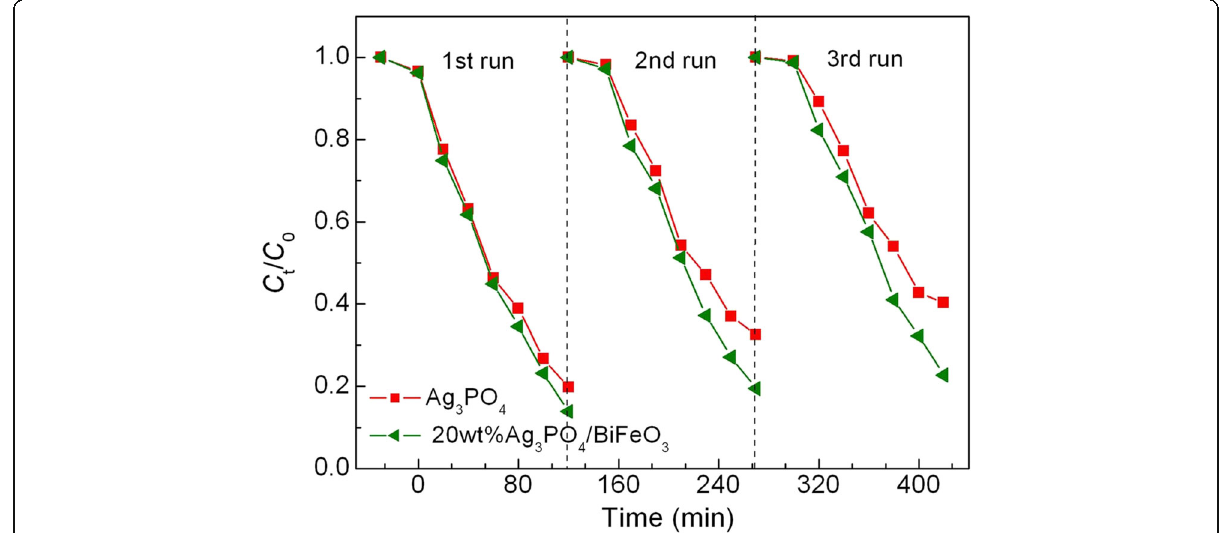
Fig. 7 Photocatalytic degradation of AO7 over Ag 3 PO 4 and 20wt%Ag 3 PO 4 /BiFeO 3 sample during three cycles